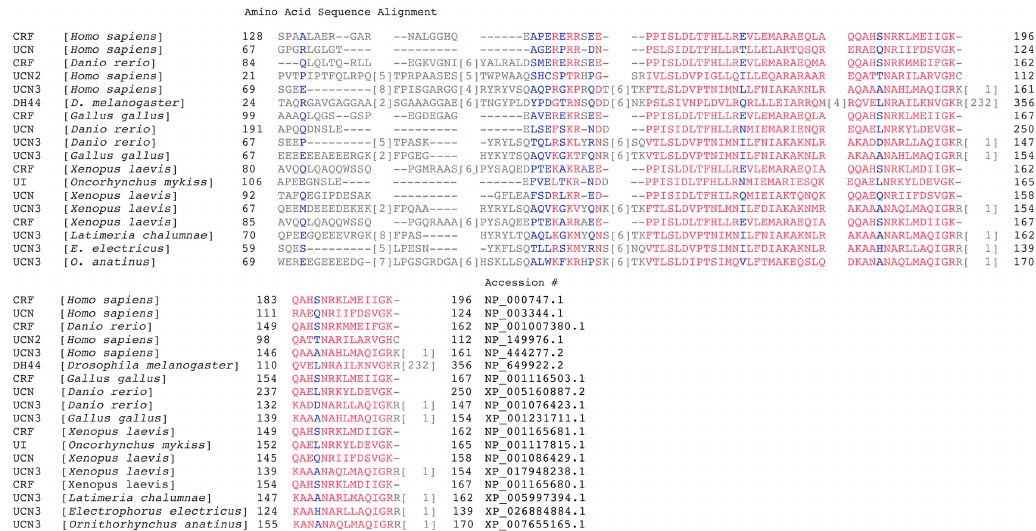
Figure 3. A comparison of examples of primary amino acid sequence from each group of CRF and urocortin precursor peptides found in the Protein data bank and generated using the multiple alignment tool from NCBI Blast. Red and blue are alignment columns with no gaps, whereas grey residues are with gaps. Highly conserved amino acids are shown in red and less conserved amino acids are shown in blue based on the residues’ relative entropy thresholds.